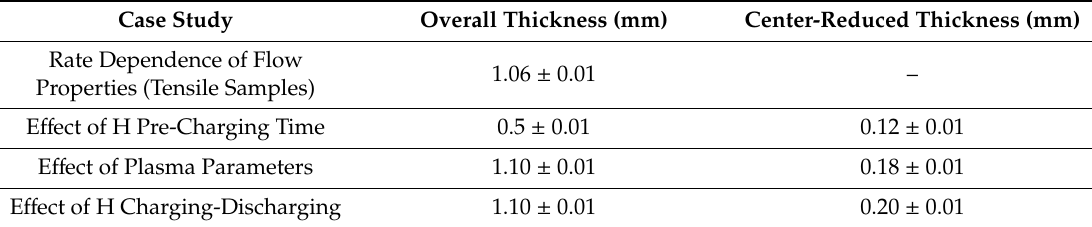
Table 2. Case studies and sample